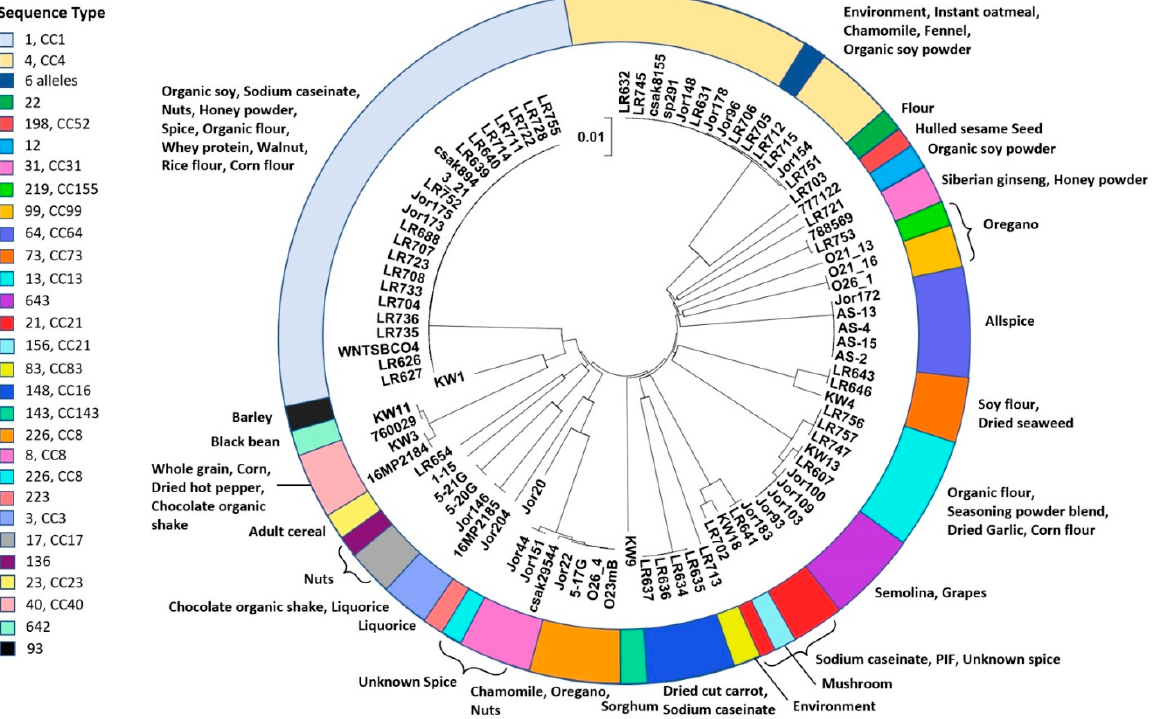
Figure 1. WGS phylogenetic analysis of C. sakazakii strains isolated from plant-origin foods and food production environments. A total of 92 genomes from our surveillance (88 plant associated and four reference strains) [13,29,30,35–38] were analyzed using a new core gene schema reported earlier